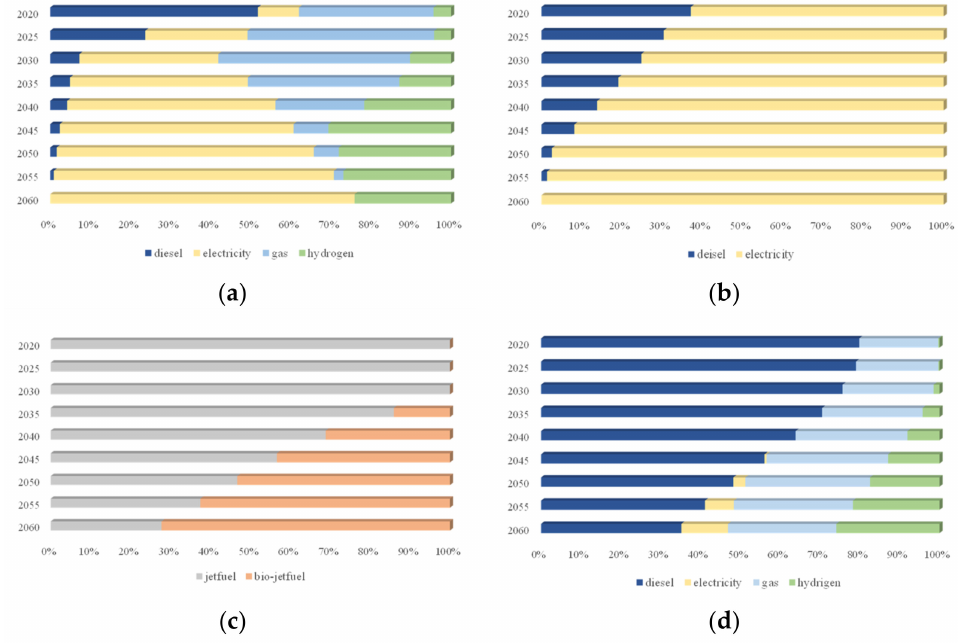
Figure 3. The structure of each freight transport subsector. ( a ) The structure of truck turnover. ( b ) The structure of railway turnover. ( c ) The structure of aircraft turnover. ( d ) The structure of vessel